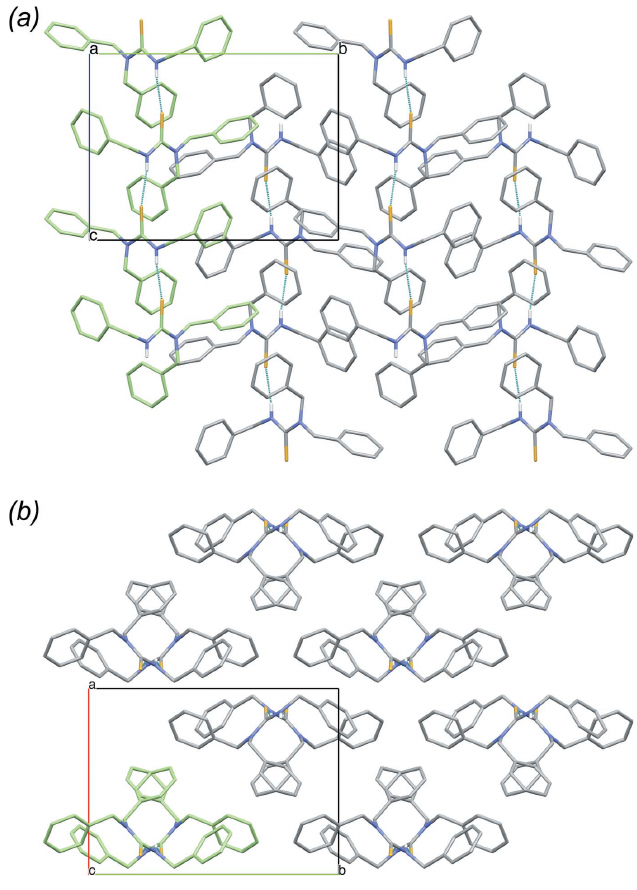
Figure 3 Packing in the structure of 1 , ( a ) viewed down the a axis, showing the N1—H1 (cid:4)(cid:4)(cid:4) S1 hydrogen bonds, linking the N , N , N 0 -tribenzylthiourea molecules into infinite chains along the [001] direction, and ( b ) viewed down the c axis, showing the columnar arrangement through alternating orientations of the molecules. A chain of four hydrogen-bonded molecules is highlighted (green). Hydrogen atoms (except involved in hydrogen bonds) are omitted for clarity.